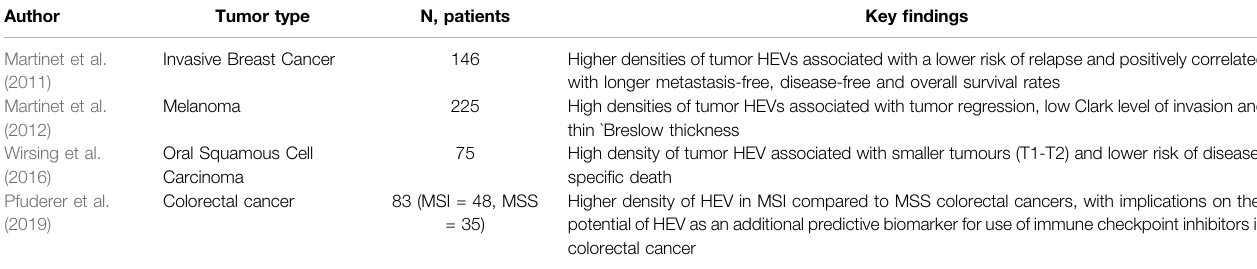
TABLE 1 | High endothelial venules as a prognostic and predictive indicator in solid